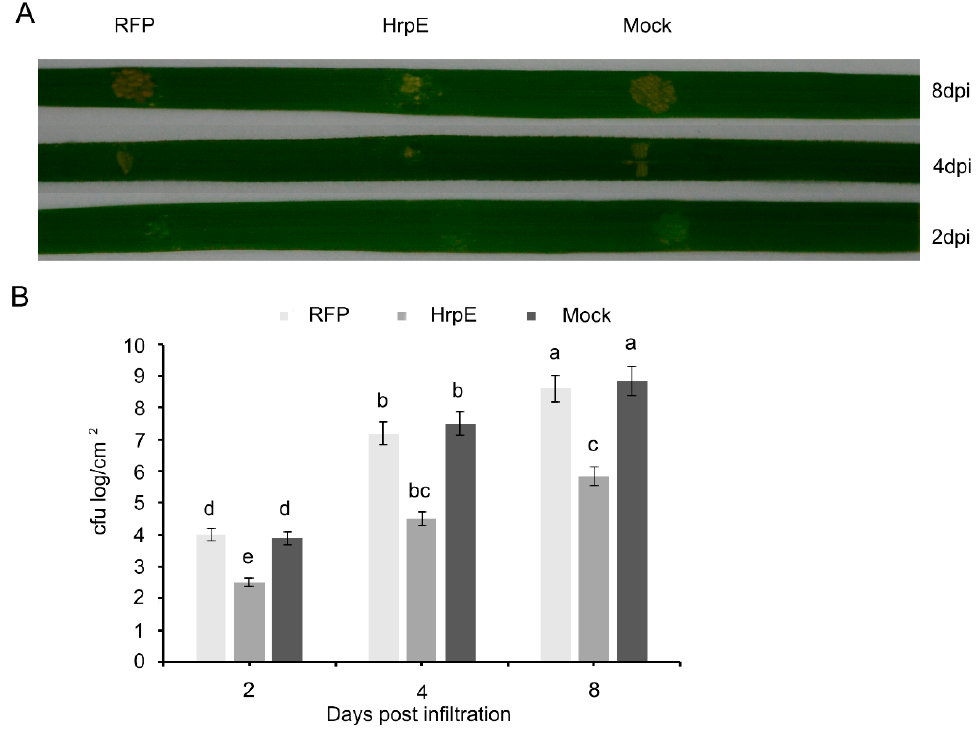
Figure 6. Xoo infections in rice leaves pre ‐ infiltrated with HrpE, at 2, 4 and 8 days post infiltration (dpi) where RFP and Mock (15 mM NaCl) served as a control ( A ). Calculation of log